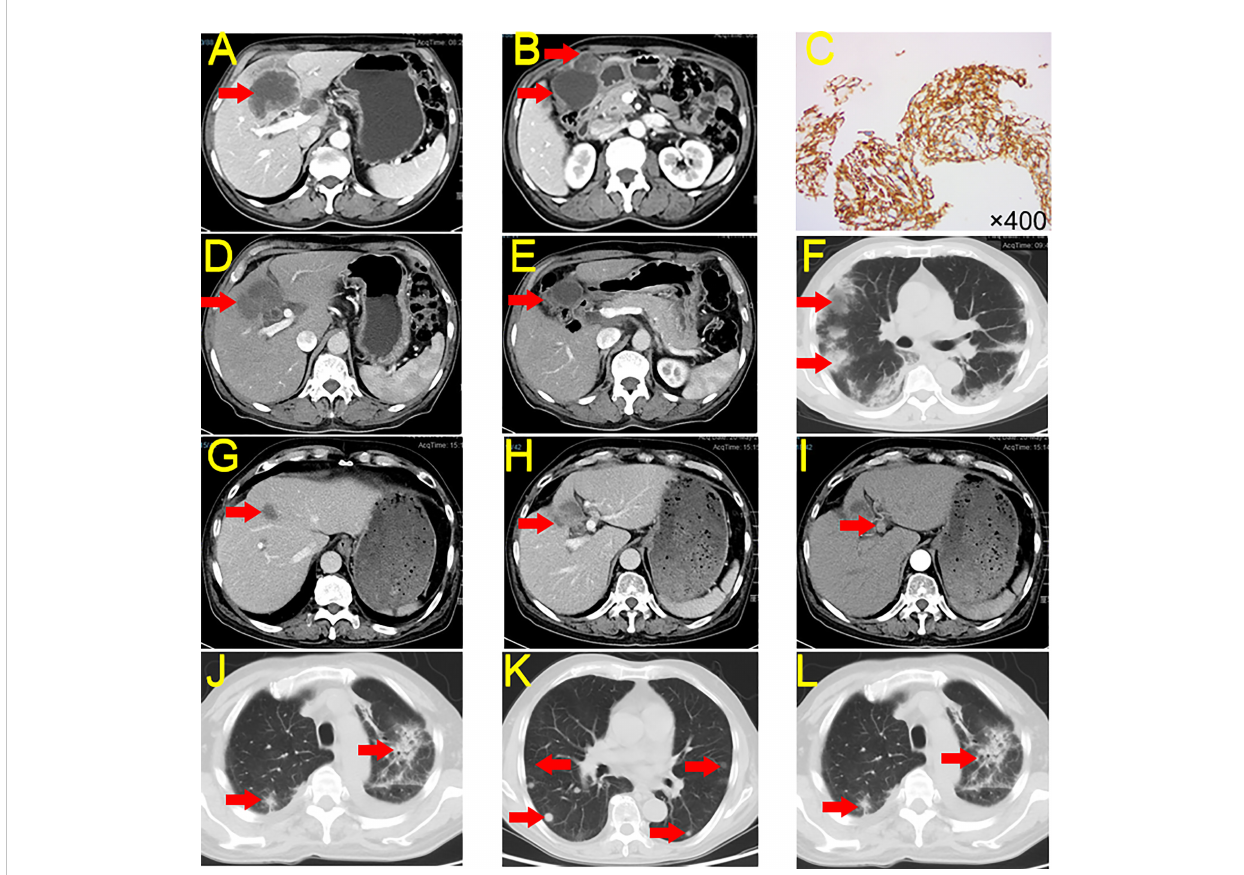
FIGURE 1 CECT and Immunohistochemistry for Case 1. (A, B) Tumor condition at fi rst CECT scan. (C) Immunohistochemistry of PD-L1 expression. (D, E) Tumor conditions after seven cycles of treatment of tislelizumab + S-1. (F) irP after treatment. (G, H) The tumor shrank after continued immunotherapy, but the patient developed irP. (I) New lymph node metastasis. (J) irP developed during postoperative tislelizumab administration. (K) Lung metastasis. (L) irP after administration of nivolumab. CECT, contrast-enhanced computed tomography; PD-L1, Programmed Cell Death-Ligand 1; irP, immune-related